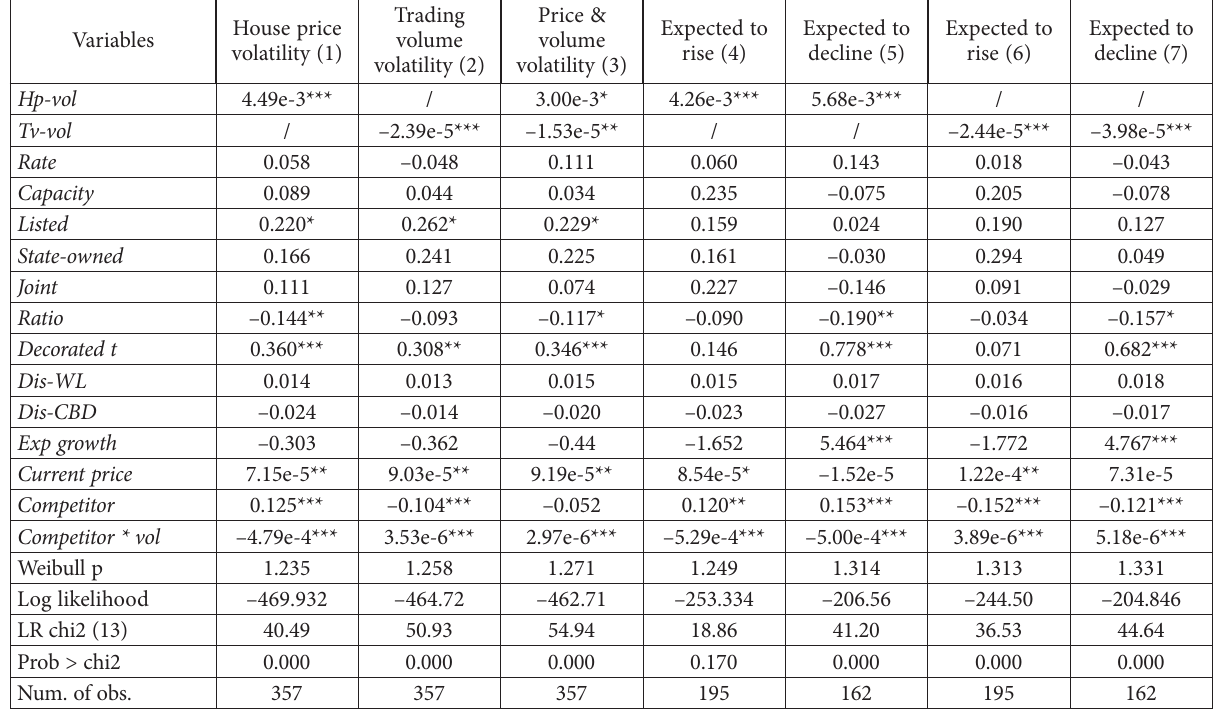
Table 3. Results of survival analysis of the timing of development in suburban areas in Hangzhou